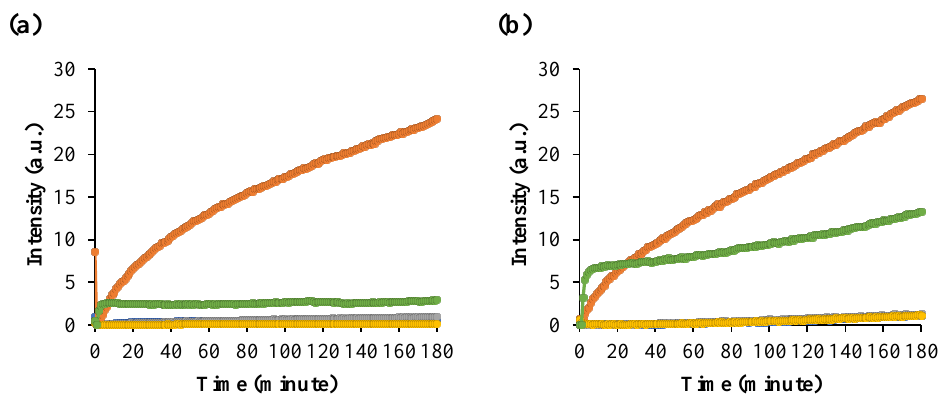
Figure 6. Time-course of RO formation of PDZ3 variants monitored by ( a ) ThT fluorescence at λ Em 480 nm. The dye concentration was 12 μM; ( b ) ANS fluorescence at λ Em 480 nm. The dye concentration was 20 μM. Protein concentration was 1 mg/mL in pH 7.5. Mixture samples were measured at 60 °C for 180 min. PDZ3-F340A/E310L (blue); PDZ3-F340A/N326L (orange); PDZ3-F340A/R309L (gray); PDZ3-F340A (yellow); and PDZ3-wt (green). Table 4. Hydrodynamic radius (nm, R h ) by DLS . The ThT fluorescence intensity of PDZ3-F340A/N326L upon incubation at pH 7.5 and 1 mg/mL at 60 ◦ C and 70 ◦ C for 3 h (Figures 6a and S7a) increased within 5 min and became 5 times higher than that of PDZ3-wt. On the other hand, the ThT fluorescence of